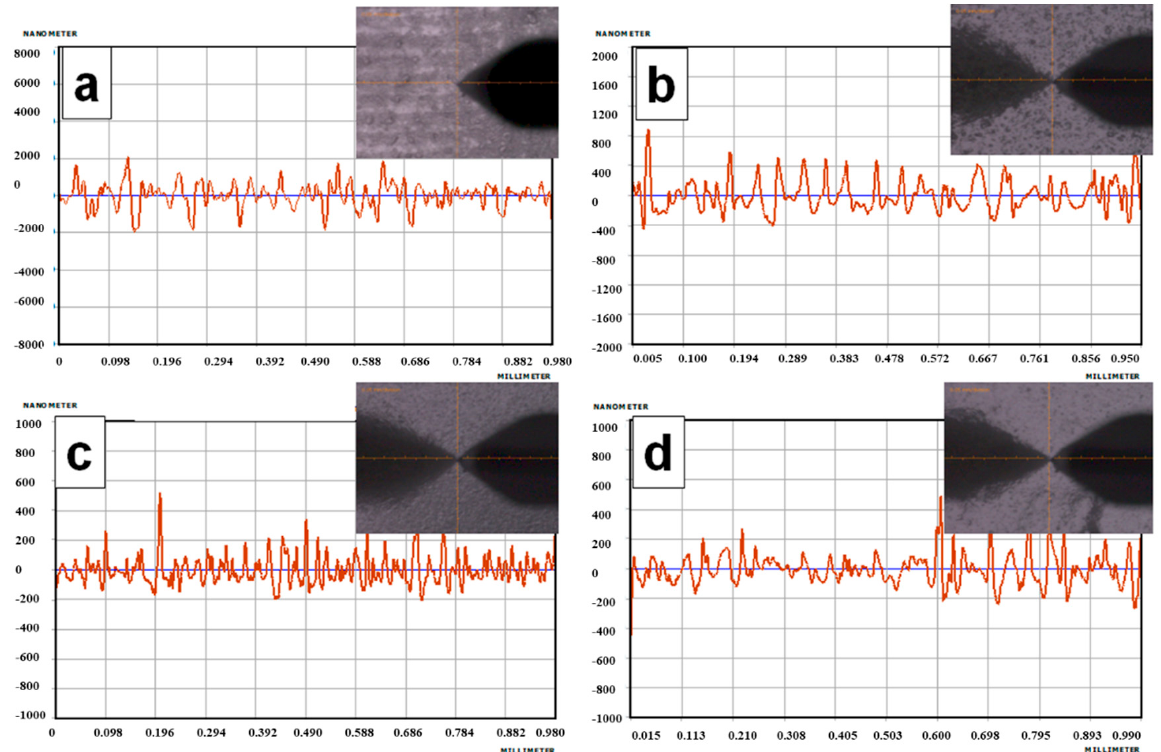
Figure 3. Microscopic images of the composite films and histograms generated by Alpha-Step D-500 Stilus profilometer ( a ) PVA/CS-0; ( b ) PVA/CS-1; ( c ) PVA/CS-2; ( d ) PVA/CS-3.